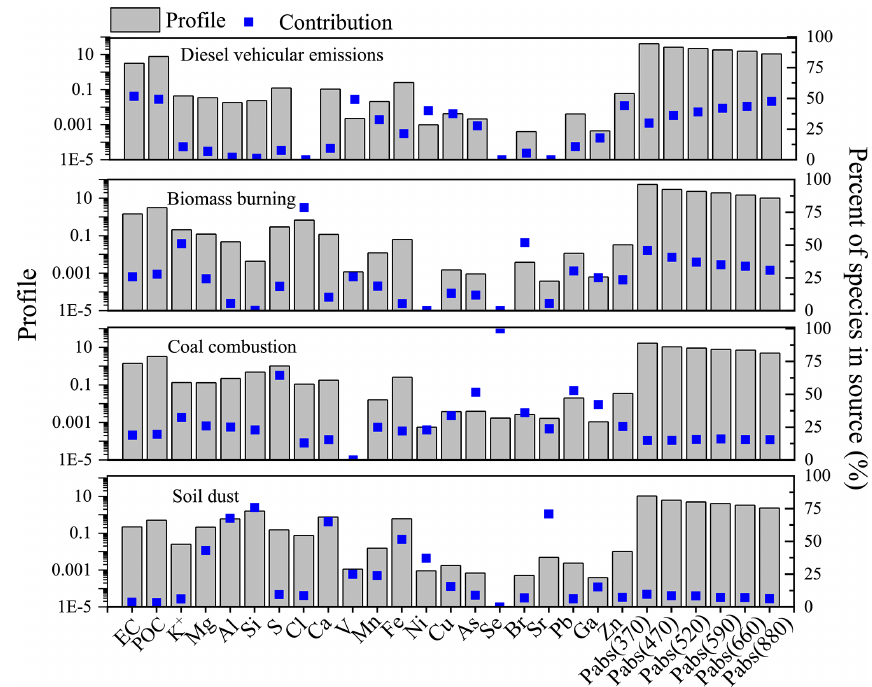
Figure 1. Four factors identified by source apportionment. Concentration (µgm − 3 ) of the chemical species and primary absorption coeffi- cients ( p abs ) ( λ ) at six wavelengths ( λ = 370, 470, 520, 590, 660, or 880nm) (Mm − 1 ) for each source are shown in grey. The blue square represents the contribution of each chemical species to the four different